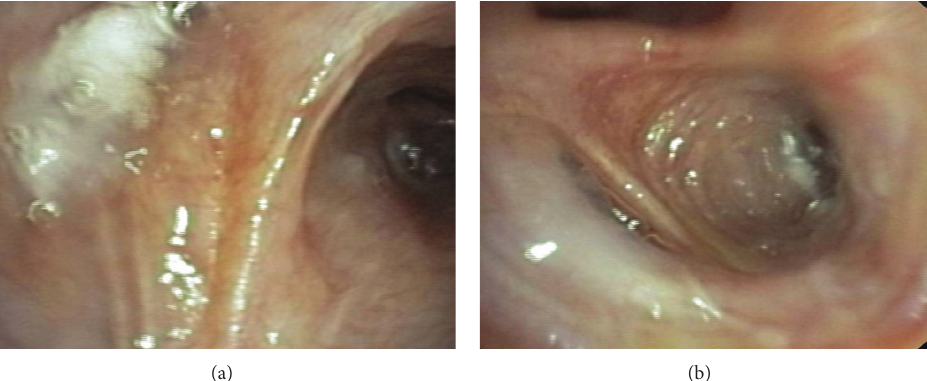
Figure 3: (a) AeriSeal foam sealants fill the targeted region of right upper lobe segment 2. (b) AeriSeal foam sealants fill the targeted region of left upper lobe segment 2. Table 1: Comparisons of the lung function parameters and 6-minute-walking test before and after endoscopic lung volume reduction. Lung function parameter Before application of AeriSeal 12 weeks after application of AeriSeal Peripheral oxygen saturation with 2L supply 93% 98% Oxygen partial pressure 58 mmHg 89mmHg FEV 1L (%